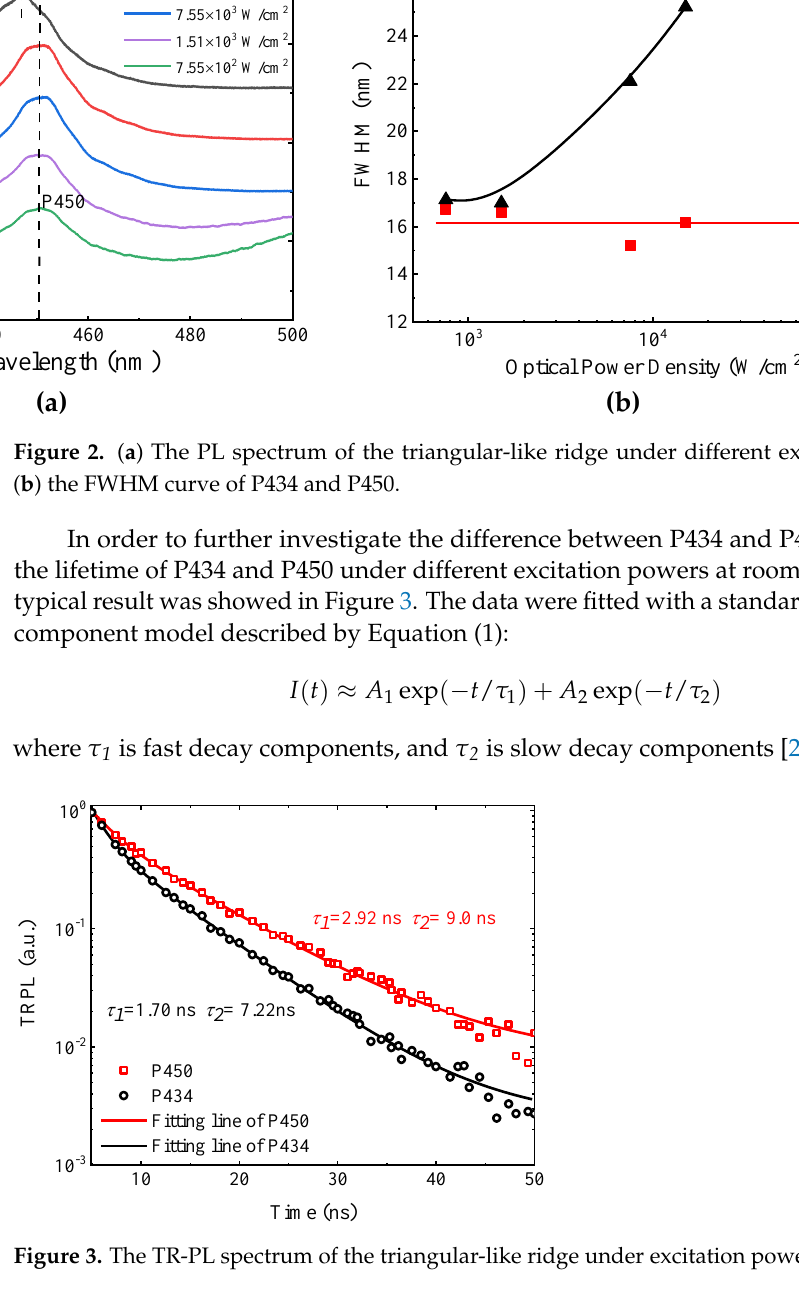
Figure 2. ( a ) The PL spectrum of the triangular-like ridge under different excitation power and ( b ) the FWHM curve of P434 and P450.